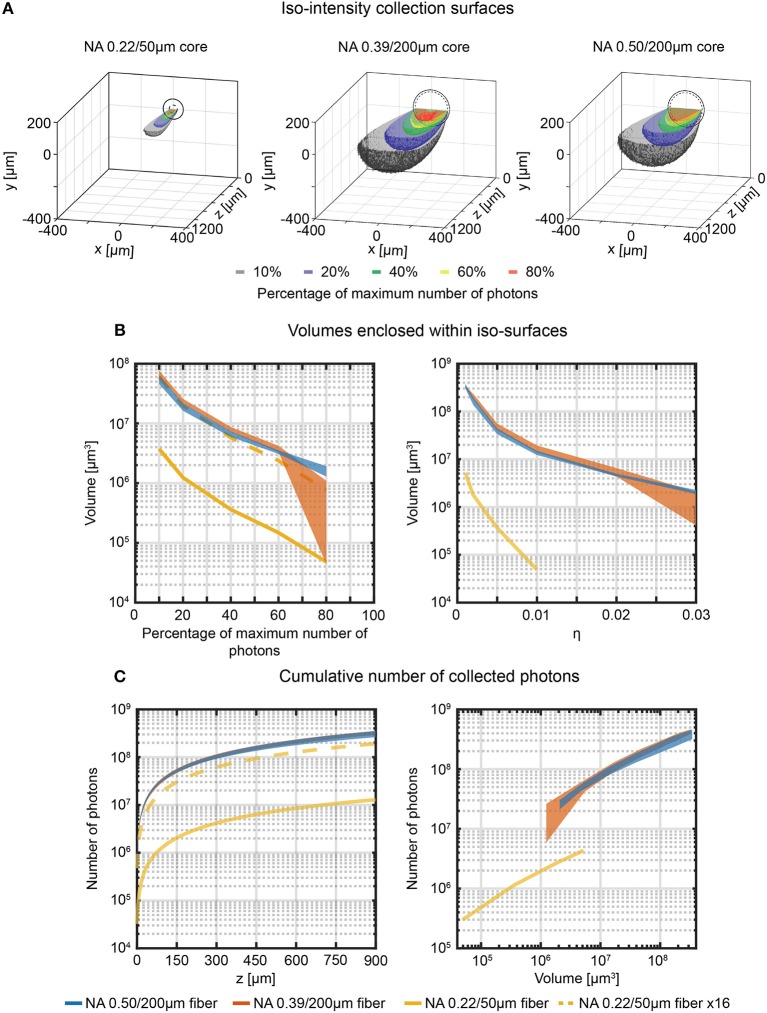
Effective light collection volumes in quasi-transparent medium. (A) Cross-sectional views of the 3-dimensional reconstructions of the collection field for 0.22/50 μm, 0.39/200 μm, and 0.50/200 μm fibers in quasi-transparent solution. Iso-intensity surfaces defining the boundaries at which the number of collected photons falls to 10%, 20%, 40%, 60%, and 80% of its maximum are shown (in black, blue, green, yellow and red, respectively). The continuous and dashed circles in the xy plane represent the cladding and the core boundaries, respectively. (B) Volumes enclosed by the iso-intensity surfaces at 10%, 20%, 40%, 60%, and 80% of the maximum number of photons (left panel) and at η = 0.001, 0.002, 0.005, 0.01, 0.02, 0.03 (right panel) for 0.22/50 μm, 0.39/200 μm, and 0.50/200 μm fibers (yellow, orange, and blue curves, respectively). The dashed yellow curve represents the data for the 0.22/50 μm fiber multiplied by a factor 16 to adjust for the smaller cross-sectional area of this fiber. The width of the curves for the 0.39NA/200 μm and 0.50NA/200 μm fibers represents mean ∓ standard deviation over four different fibers. (C) Cumulative number of photons collected by the three fibers as a function of the distance from the fiber facet (left panel, number of photons are shown in a volume 900 μm × 600 μm × z) and as a function of the volume enclosed within the iso-surfaces at fixed η (right panel). The dashed yellow curve represents the data points relative to the 0.22/50 μm fiber multiplied by a factor 16. The width of the curves for the 0.39NA/200 μm and 0.50NA/200 μm fibers represents mean ∓ standard deviation over four different fibers.